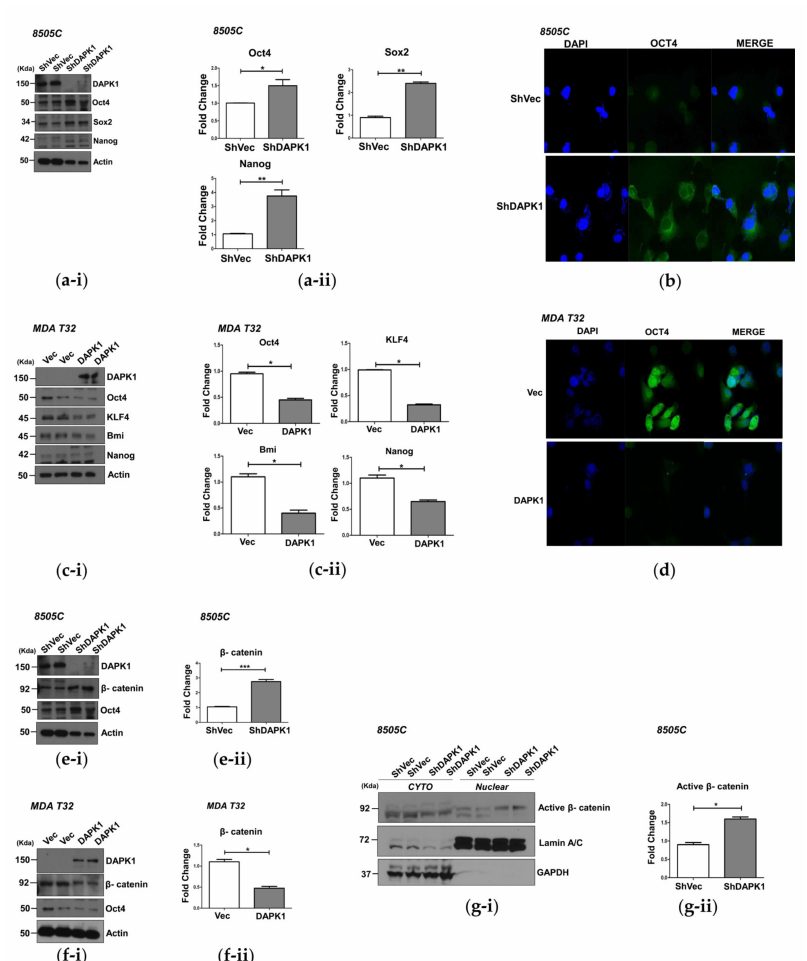
Figure 4. DAPK1 is associated with the migration and invasion ability of 8505C, MDA-T32, and BCPAP cancer cells. ( a-i ) Transwell assays were performed in the 8505C cells after stable knockdown of DAPK1 . A representative image was acquired 36 h after the initial seeding (pore size 0.8 µ m). The image was acquired at a magnification of 100 × ; scale bar represents 50 µ m. ( a-ii ) Graph of the quantified results of ( a-i ). There was significantly more migration of the sh DAPK1 - 8505C cells than the shVector -8505C cells. The expression level of sh DAPK1 -8505C cells was confirmed by Western blot. ( b-i ) Transwell DAPK1 is a negative regulator of thyroid cancer cell stem cell properties. ( a , b ) The expression of stem cell markers in 8505C cells after stable DAPK1 knockdown. ( a-i ) Protein expression of Oct4 , Sox2 , and Nanog in DAPK1 -stable KD 8505C cells. ( a-ii ) Quantification of the protein expression level. Oct4, Sox2, and Nanog expression increased significantly after DAPK1 KD. ( b ) Immunofluorescence staining of Oct4 , which showed increased cytoplasmic expression in shDAPK1- 8505C cells compared with shVector-8505C cells. ( c , d ) The expression of stem cell markers in MDA-T32 cells after stable overexpression of DAPK1 . ( c-i ) The protein expression of Oct4, KLF4, Bmi, and Nanog in DAPK1 -overexpressing MDA-T32 cells. ( c-ii ) Quantification of the protein expression level, and the expression of Oct4, KLF4, Bmi, and Nanog decreased significantly after DAPK1 overexpression in MDA-T32 cells. ( d ) Immunofluorescence staining of Oct4 , which showed decreased cytoplasmic expression after DAPK1 overexpression in MDA-T32 cells. ( e – g ) The β -catenin protein level in MDA-T32 and 8505C cells was investigated after DAPK1 expression modulation. ( e-i ) The protein expression of β -catenin increased significantly in sh DAPK1 - 8505C cells compared with the shVec-8505C cells. ( e-ii ) Quantification of the β -catenin protein level. ( f-i ) The protein expression of β -catenin significantly decreased in DAPK1 -overexpressing MDA-T32 cells compared with the control. ( f-ii ) Quantification of the β -catenin protein level. ( g-i ) The protein expression of active β -catenin in the nucleus increased significantly in sh DAPK1 -8505C cells compared with shVec-8505C cells. ( g-ii ) Quantification of the active β -catenin protein level in the nuclear fraction. GAPDH and lamin were used as loading controls for the membrane and nuclear fraction, respectively. Asterisks ( p < 0.05 (*), p < 0.01 (**), p < 0.001 (***)) indicate significant differences in the statistical analyses. Each data point represents the mean ± standard error of three independent